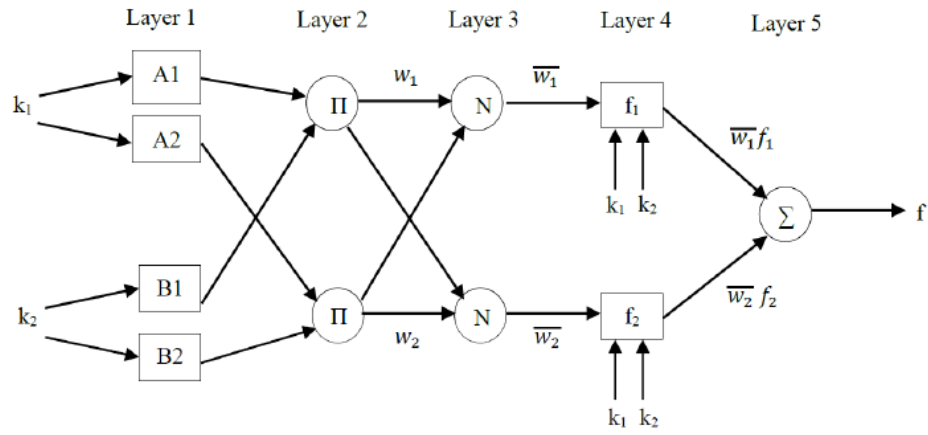
Figure 7. The architecture of a neuro ‐ fuzzy inference system .